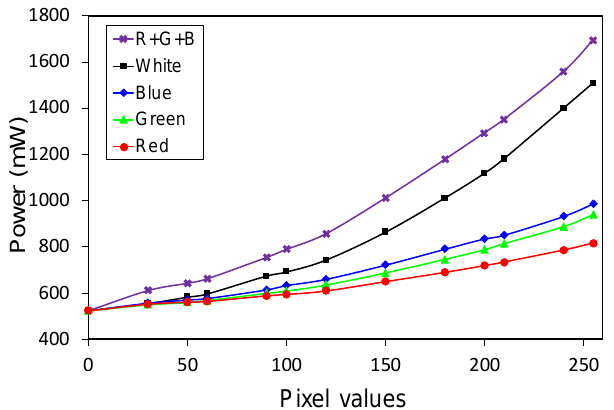
Figure 1. Display power consumption of a Galaxy S3 smartphone when a different single color is displayed on the screen: Red, Green, Blue, and White. R + G + B means the simple sum the power consumed when Red, Green, and Blue colors are displayed independently.